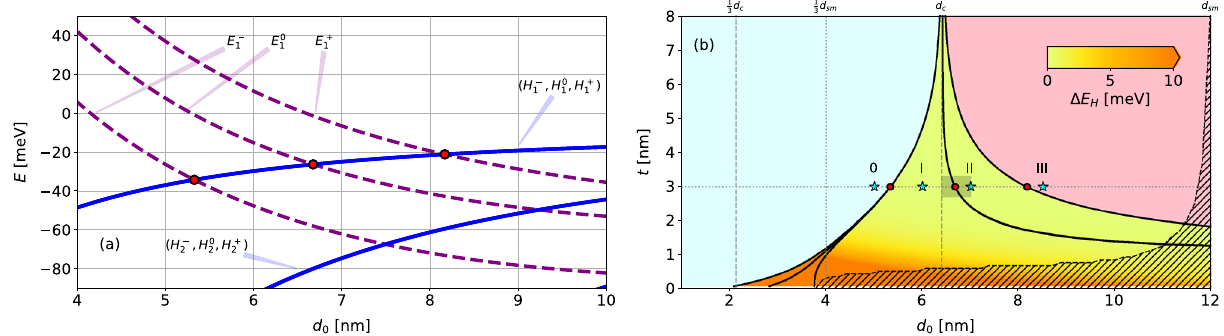
0 subband edges and the H-like subbands as a function of d 0 , = 3 nm line correspond to those in = 3 nm line mark the points (0, I, II, III) corresponding to the phases = 6.7 nm and t 3 nm marks the parameters of the = = 0.3 nm in both d 0 and ± E L 1 E C 1 E R 1 (cid:30) , (cid:31) (cid:30) and (cid:31) (cid:30) . On the other hand, the three H-like sub- (cid:31) (cid:31) (cid:31) ± ± ± H ν 1 (cid:30) are strongly localized (cid:31) ±